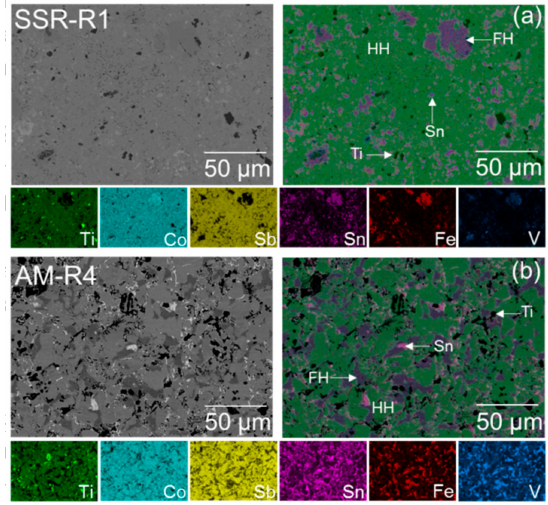
Figure 2. Backscattered scanning electron microscopy images, composite and individual elemental maps for the ( a ) SSR-R1 and ( b ) AM-R4 Ti 0.7 V 0.3 Co 0.85 Fe 0.15 Sb 0.7 Sn 0.3 samples. The compositions of the phases present are discussed in the text and are listed in Table 3. Table 3. SEM-EDX compositions for the half- and full-Heusler (HH and FH) phases present in